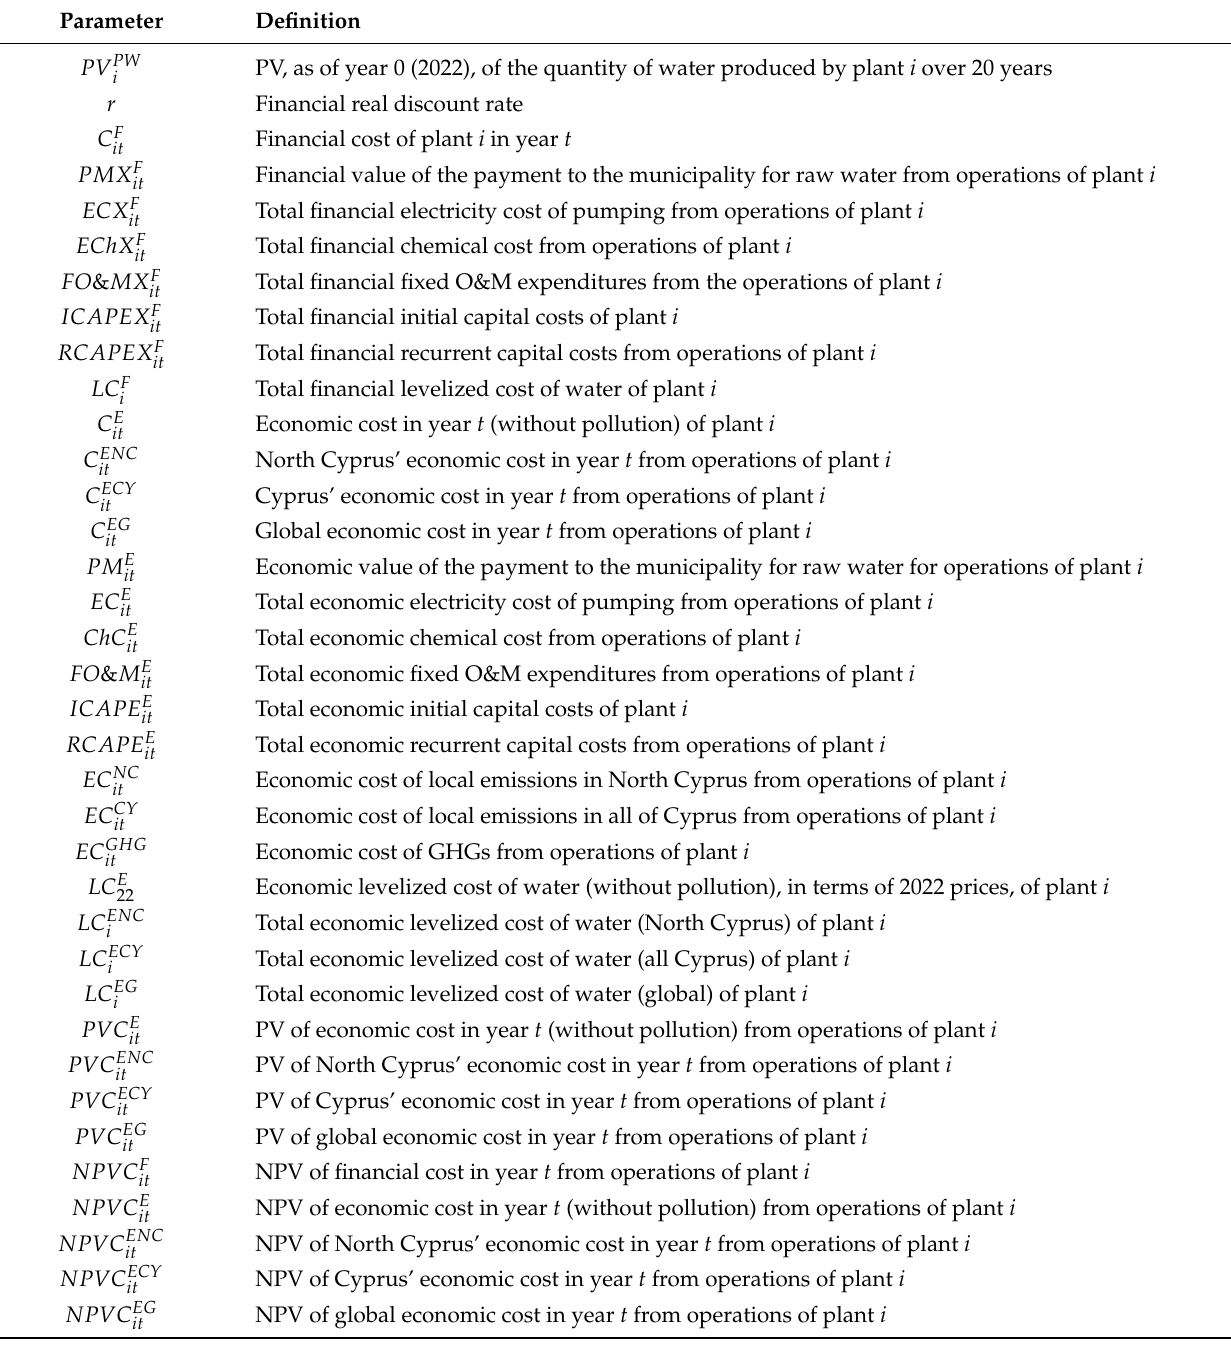
Table 2 lists all parameters used in Equations (1)–(21) with their definitions. Table 2. Table of